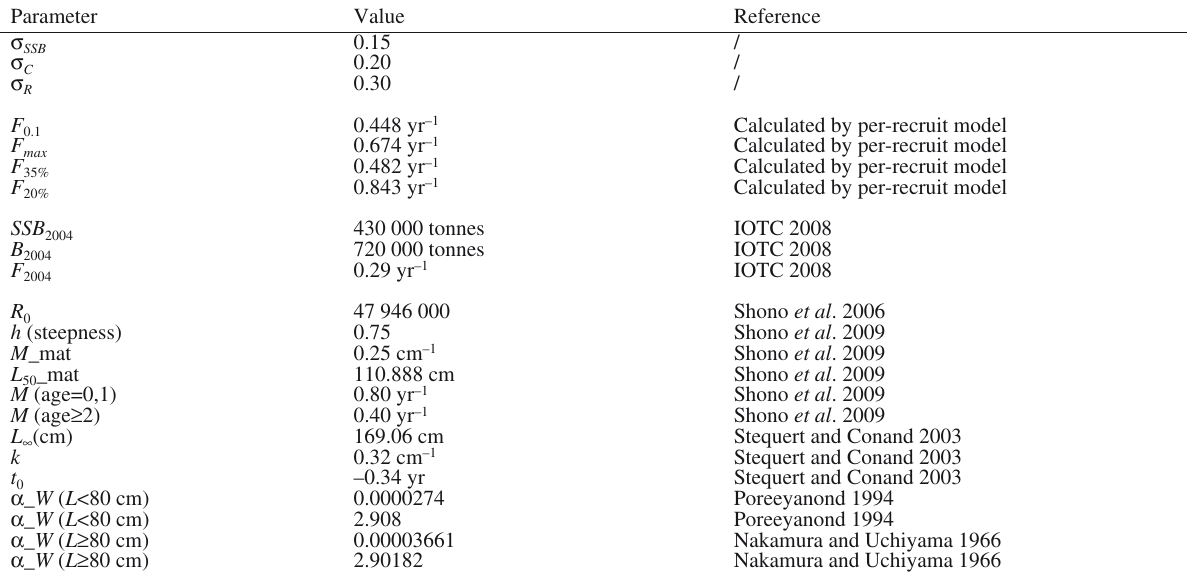
Table 1. – Values defined for various parameters used in the simulation.